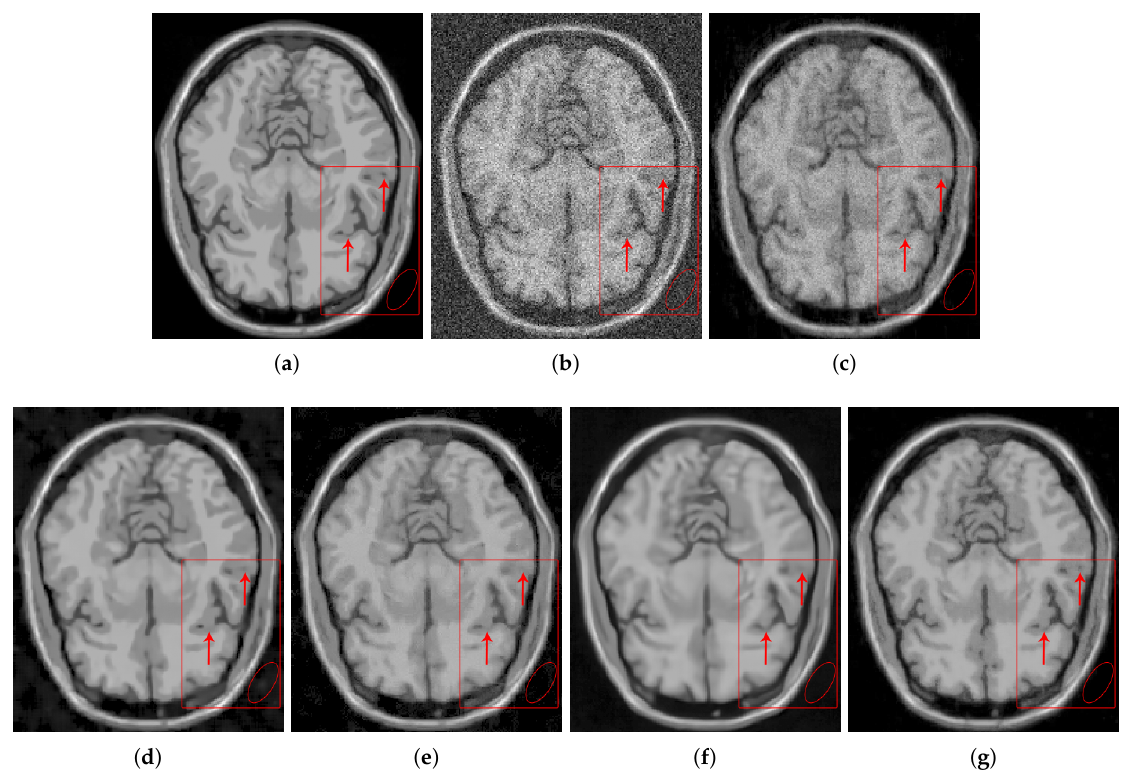
Figure 10. Comparison of the denoising methods on the T1w synthetic noise-free MR image corrupted with 9% Rician noise. ( a ) Original synthetic noise-free MR image. ( b ) Original image corrupted with 9% Rician noise. ( c – g ) Denoising results of the KSVD, PRINLM, BM4D, DnCNN and the proposed method NLSD.